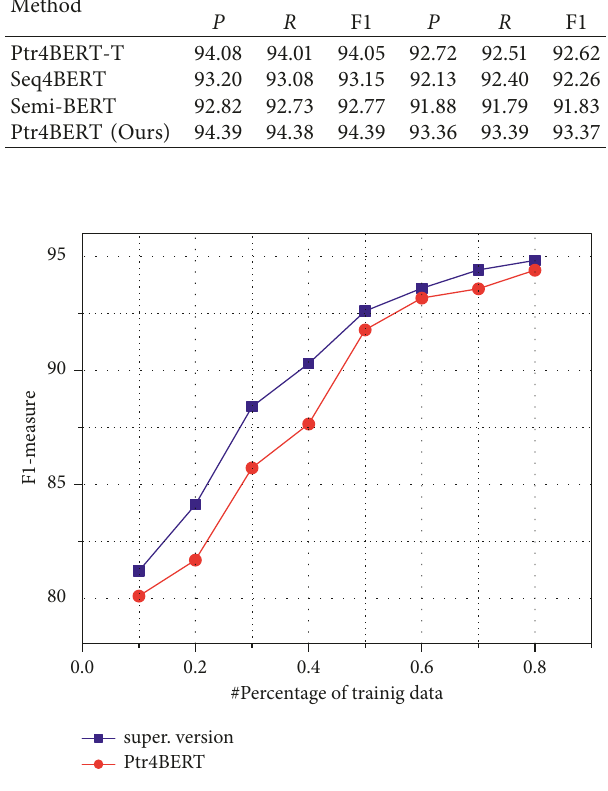
Figure 5: Performances of the proposed Ptr4BERT and its su- pervised version.